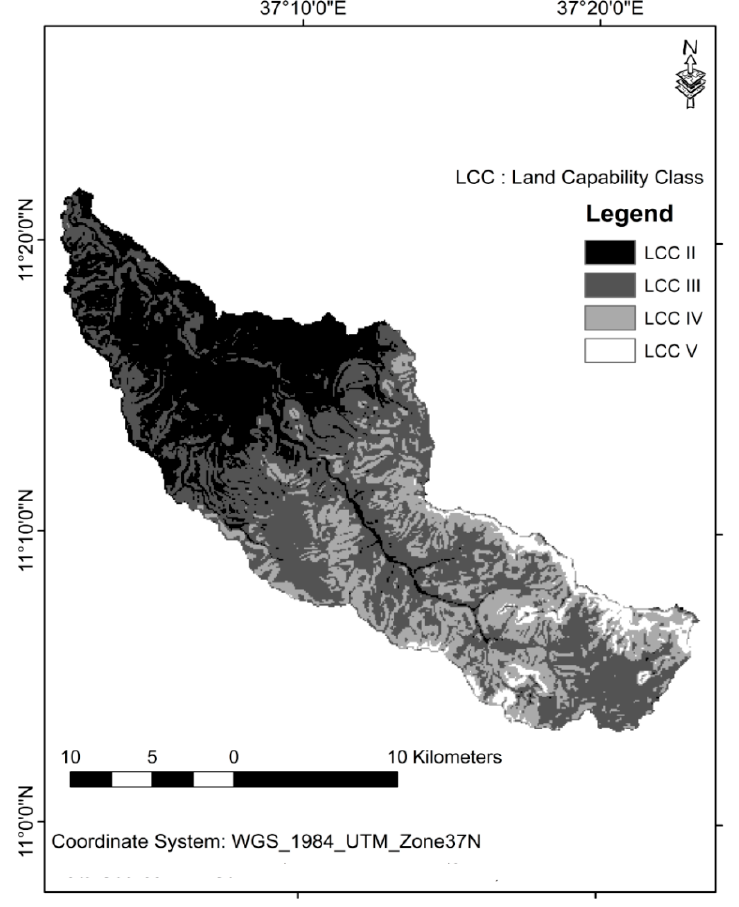
Figure 5. The distribution of LCC among the agro-ecological zones of the Jema watershed. Table 5. Area coverage of different LCCs in the entire study site.